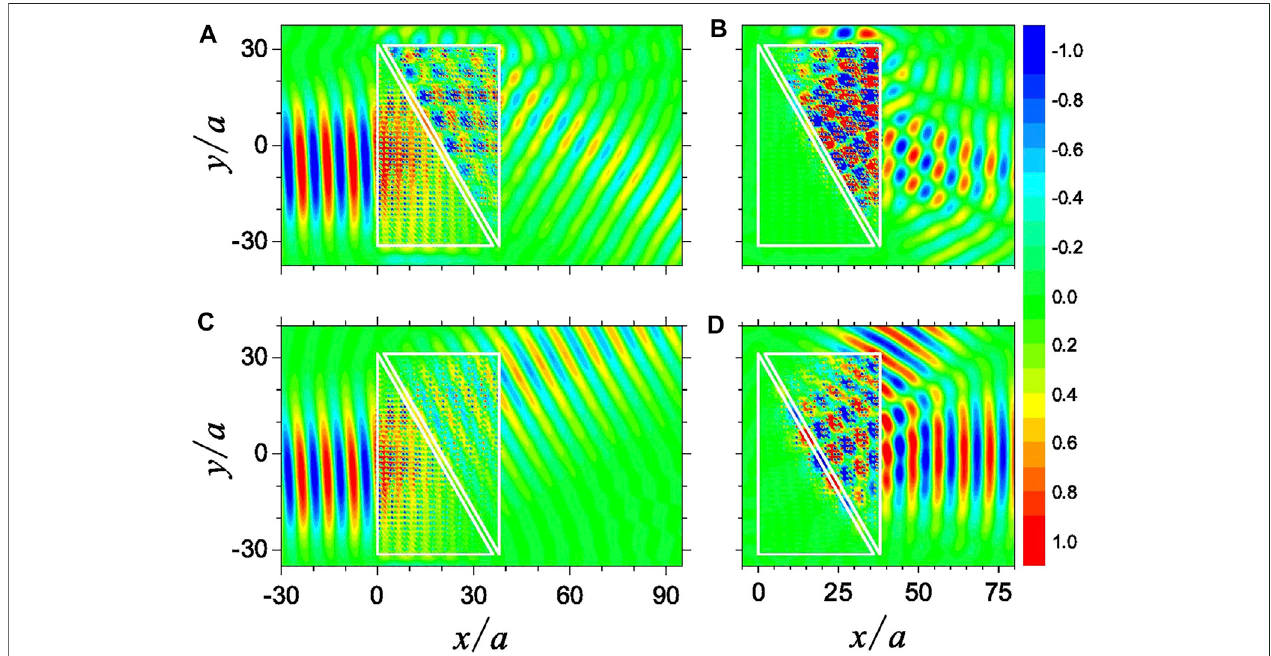
FIGURE 4 | Electric fi eld patterns illustrating the unidirectional propagation by the HSMM made up of the EZI and ENI with the LHS incident Gaussian beam exhibitingthe “ passing ” state (A) ,buttheRHSincidentGaussianbeamexhibitingtotalre fl ection (B) .FortheHSMMmadeupoftheEZIandEPI,theelectric fi eldpatterns also exhibitthe “ passing ” statefortheLHSincidence (C) andthetotalre fl ectionfortheRHSincidence (D) .TherodradiicorrespondingtotheENI of n eff,1 = − 1,theEZIof n eff,2 =0,andtheEPIof n eff,3 =1are r 1 =3.64 mm, r 2 =3.82 mm,and r 3 =4.2 mm,respectively,asmarkedin Figure3A .TheBMFexertedupontwoHSMMsis H 0 = 500 Oe, and the operating frequency is f = 2.5 GHz, kept